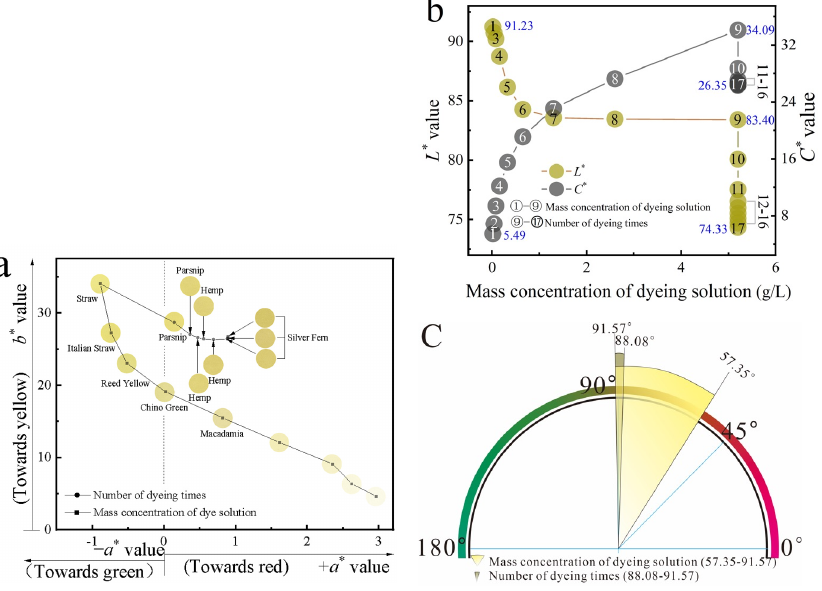
Figure 5. Color range of cotton fabrics dyed with P. amurense in pre-mordanting processes. ( a ) a * and b * range, ( b) lightness L * range and purity C * range, ( c ) the hue angle h ° range.